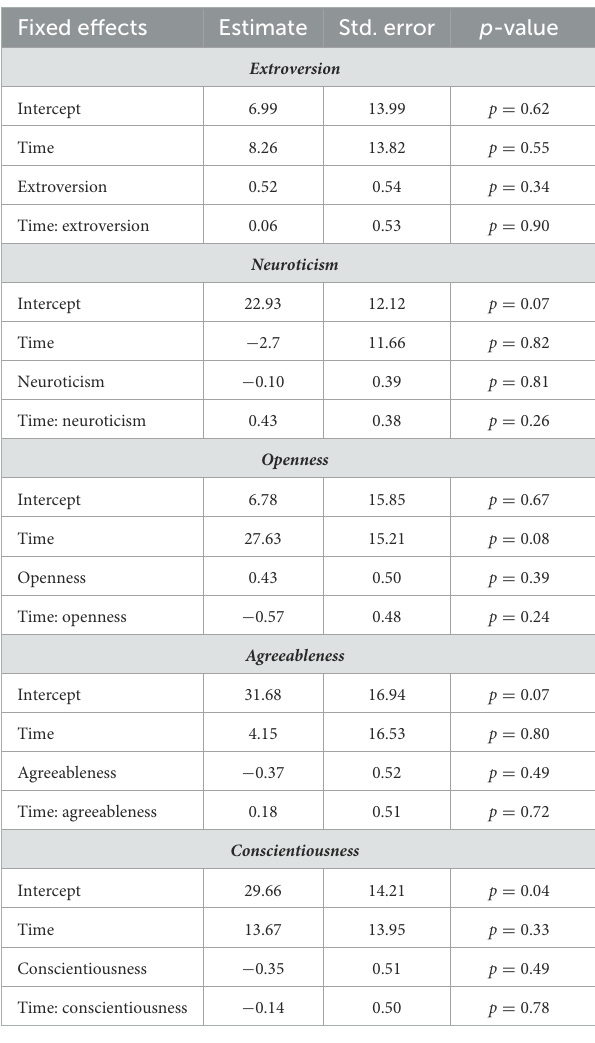
TABLE 2 Results of the linear mixed effects model, where the amount shared in the Dictator Game is the dependent variable, and the personality traits are the independent